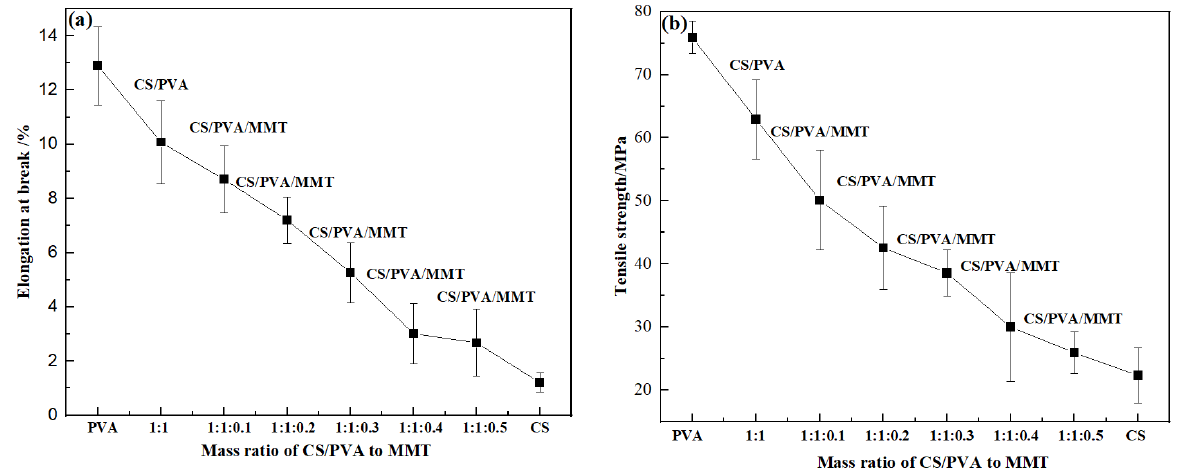
Figure 1. Effect of the mass ratio of CS/PVA to MMT on the mechanical properties of films.